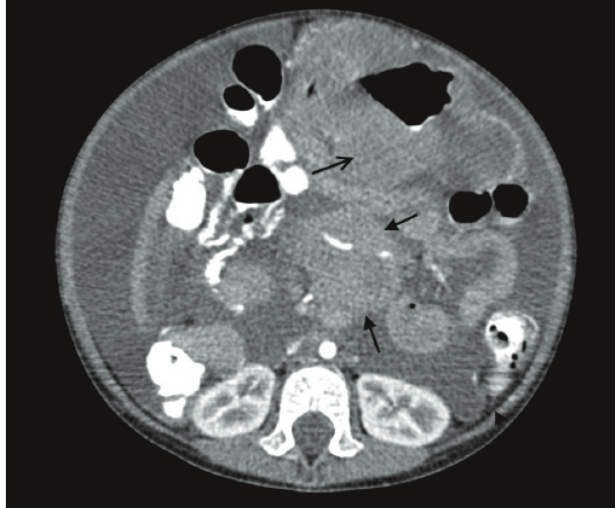
Fig. 2. Axial CT image with intravenous contrast in a 2-year-old girl diagnosed with Burkitt’s lymphoma demonstrates the sandwich sign (filled arrows). Note the diffuse lymphomatous infiltration of the stomach (open arrow) and